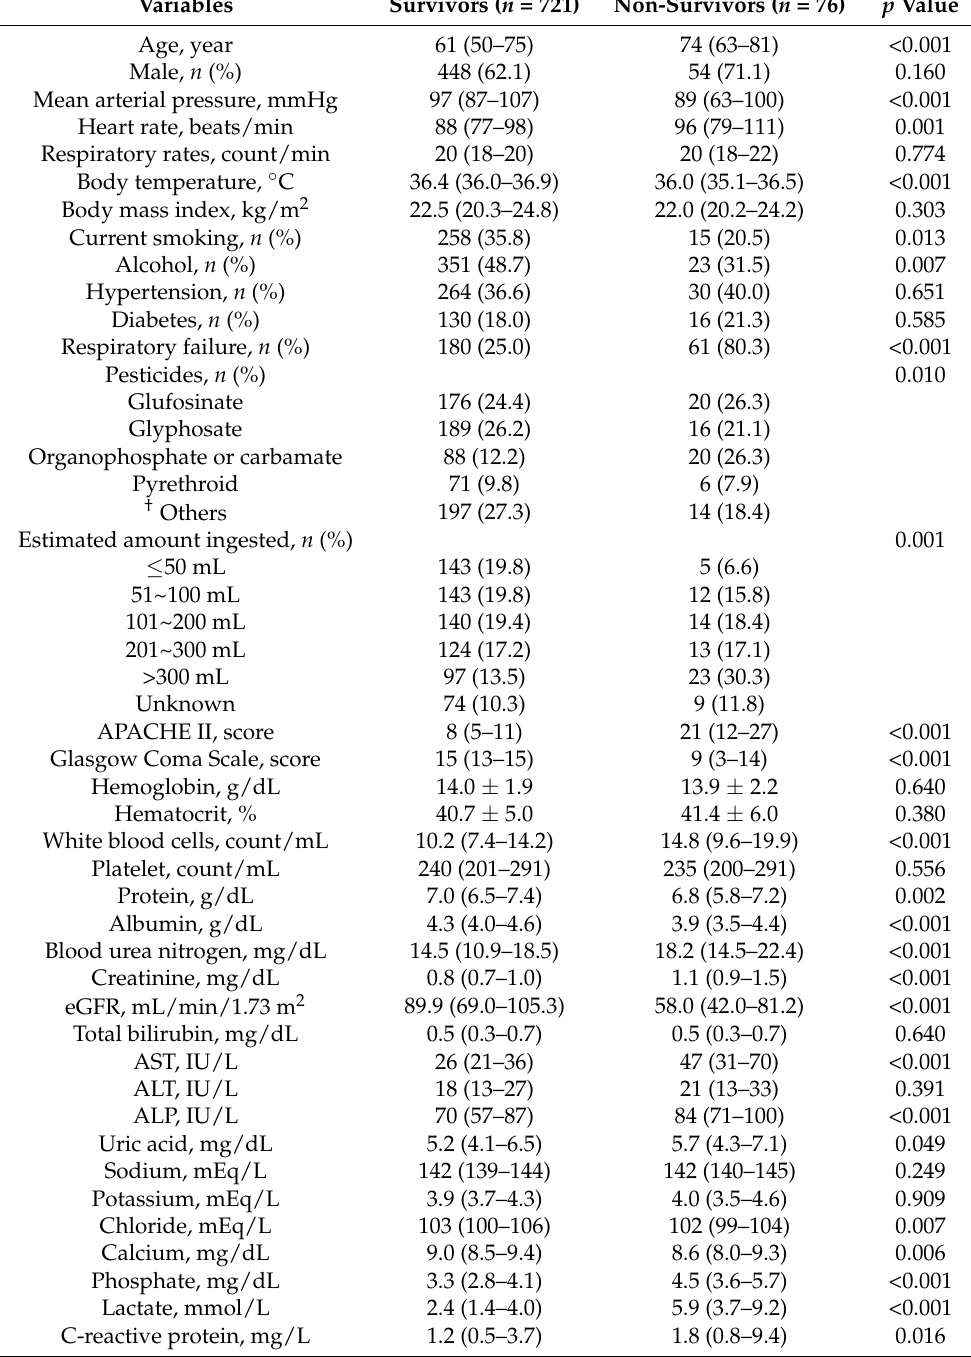
Table 1. Baseline characteristics of enrolled patients ( n =